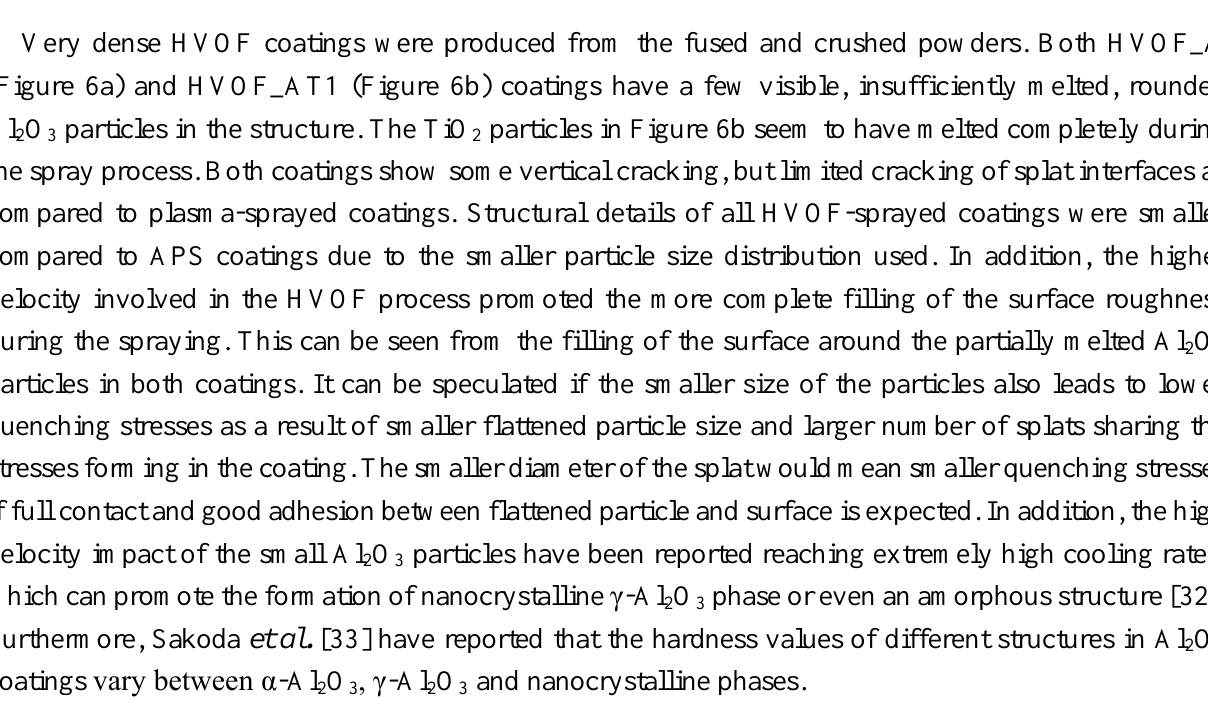
Figure 6. Microstructure of ( a ) HVOF_A and ( b ) HVOF_AT1 coatings. FE-SEM